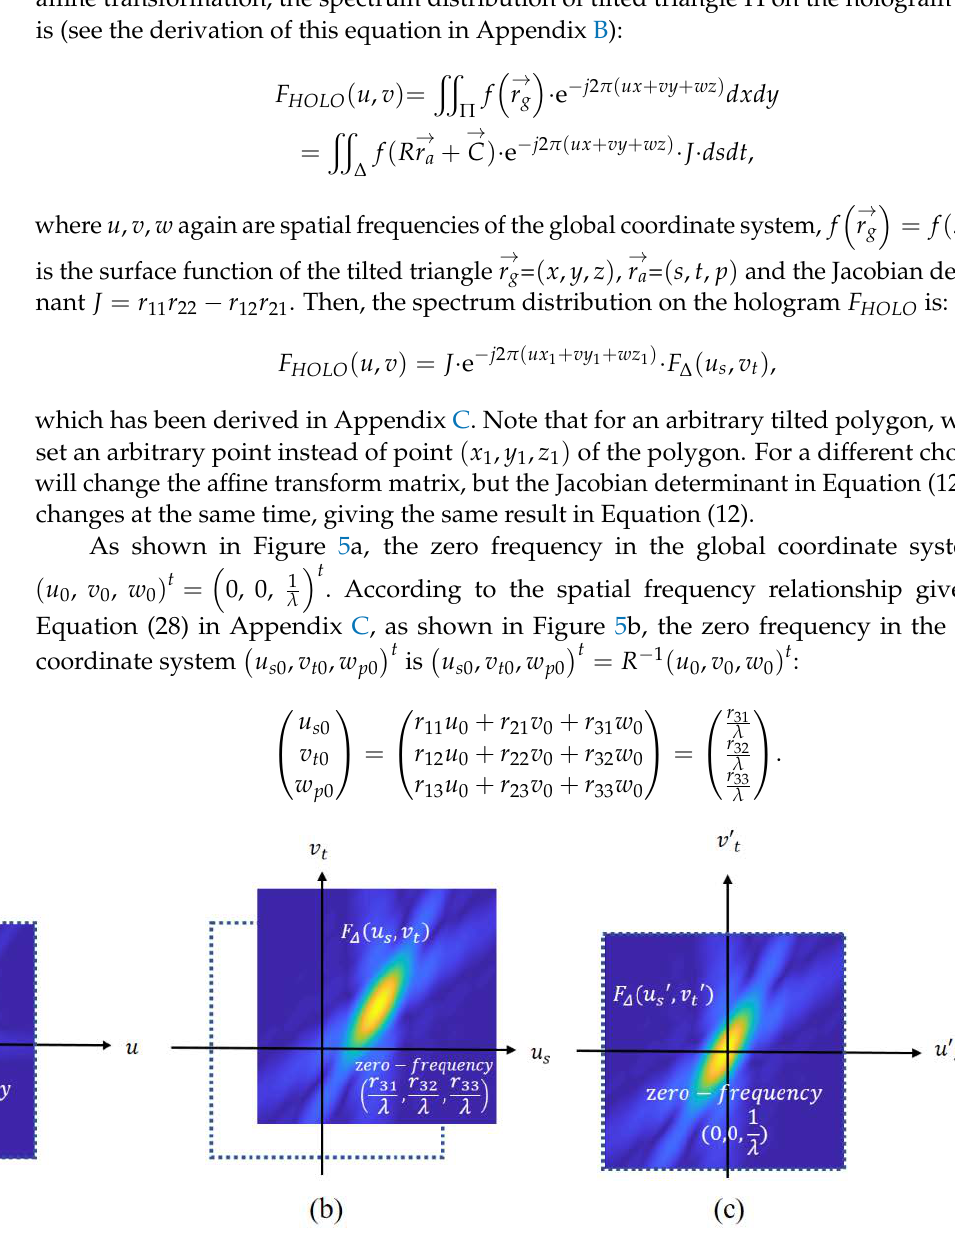
Figure 5. Spectrum shift problem. ( a ) Spectrum in global coordinate system, ( b ) spectrum in affine system and ( c ) spectrum with frequency offsetting.